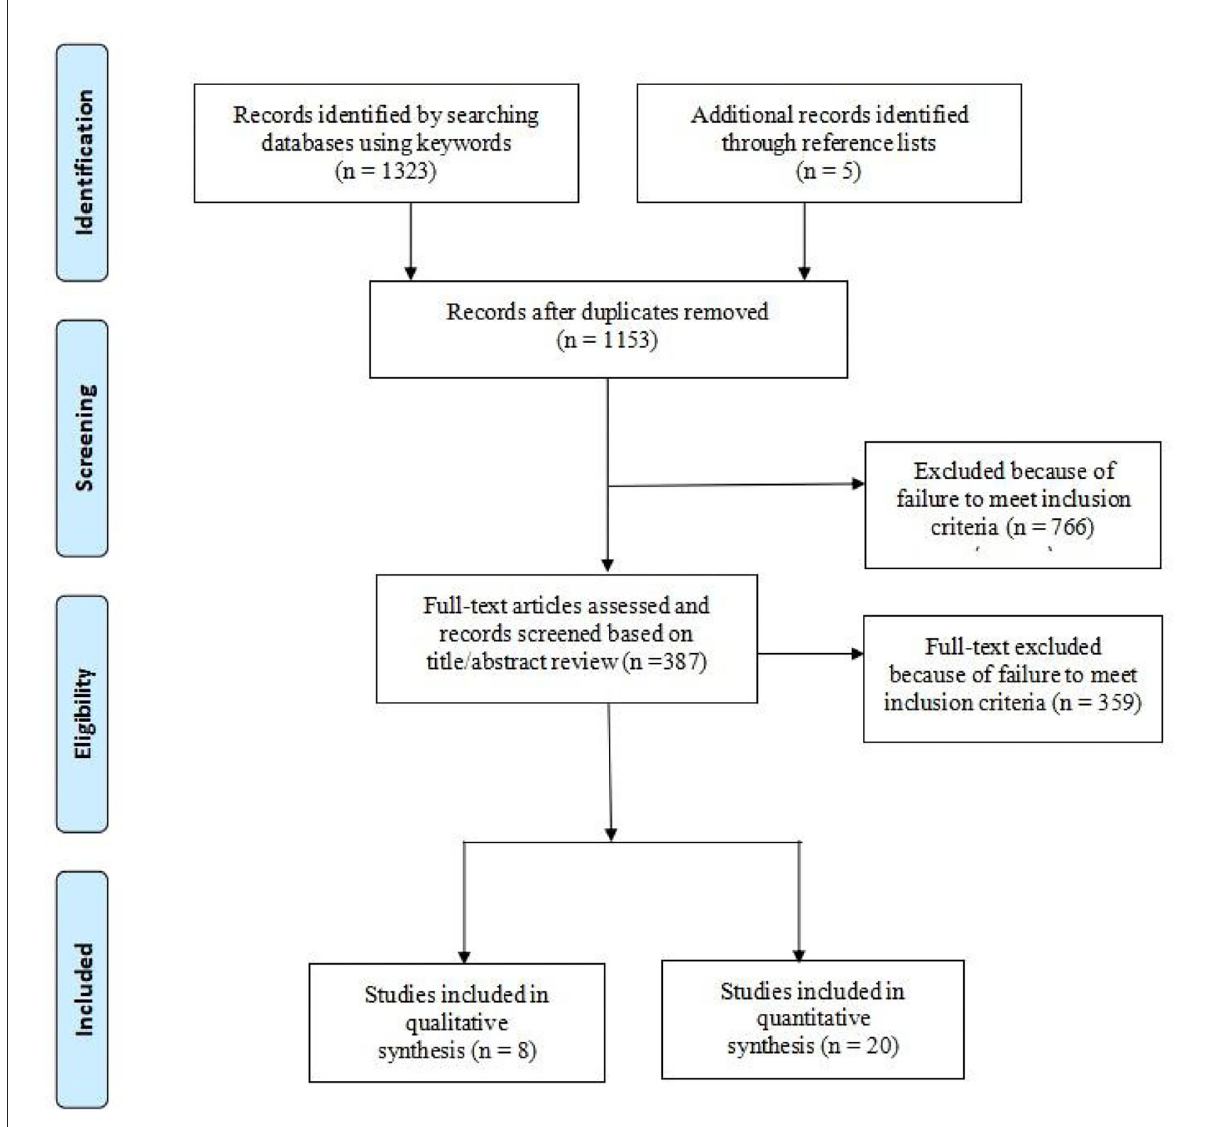
FIGURE1 PRISMA flow